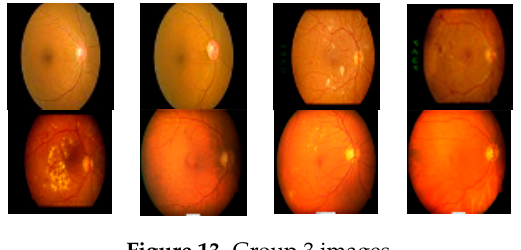
Figure 13. Group 3 images.